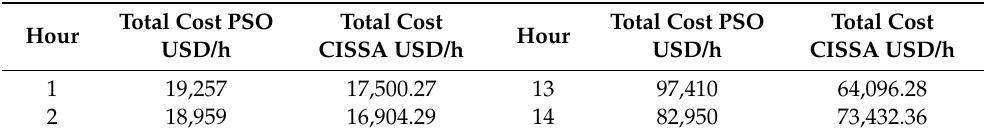
Table 21. Total cost comparison between CISSA and PSO.